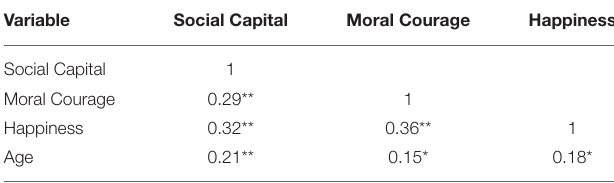
TABLE 3 | Correlation coefficient of the continuous